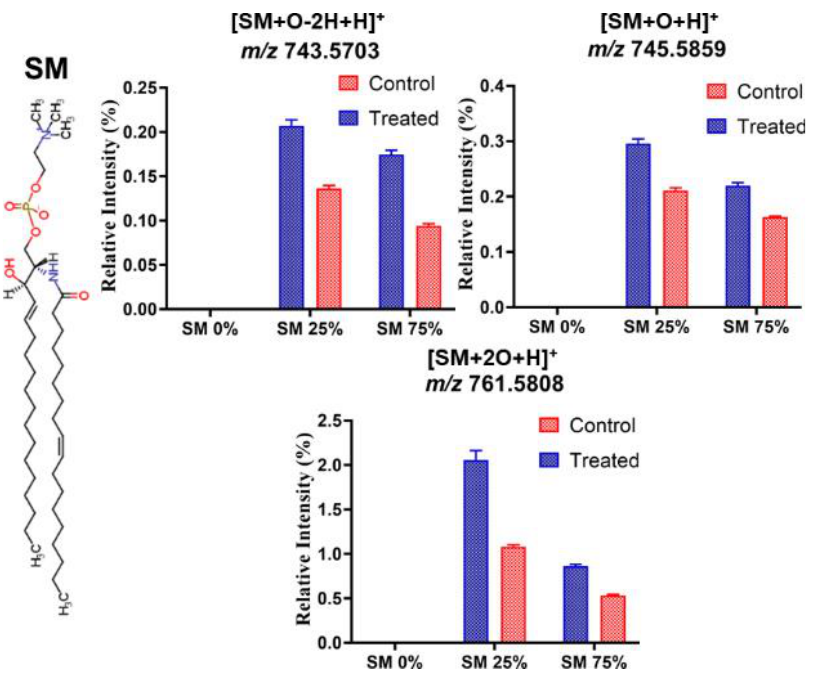
Figure 4. The relative intensity for different SM oxidation products obtained from lipid bilayers with different SM fraction after 30 min plasma treatments (Treated) and after auto oxidation (Control) ( n = 3). Relative intensity of each lipid peroxidation product (LPP) is calculated as the peak area of LPP divided by the peak area of unmodified SM in the same sample. Note that the different graphs have different scaling of the y -axis.